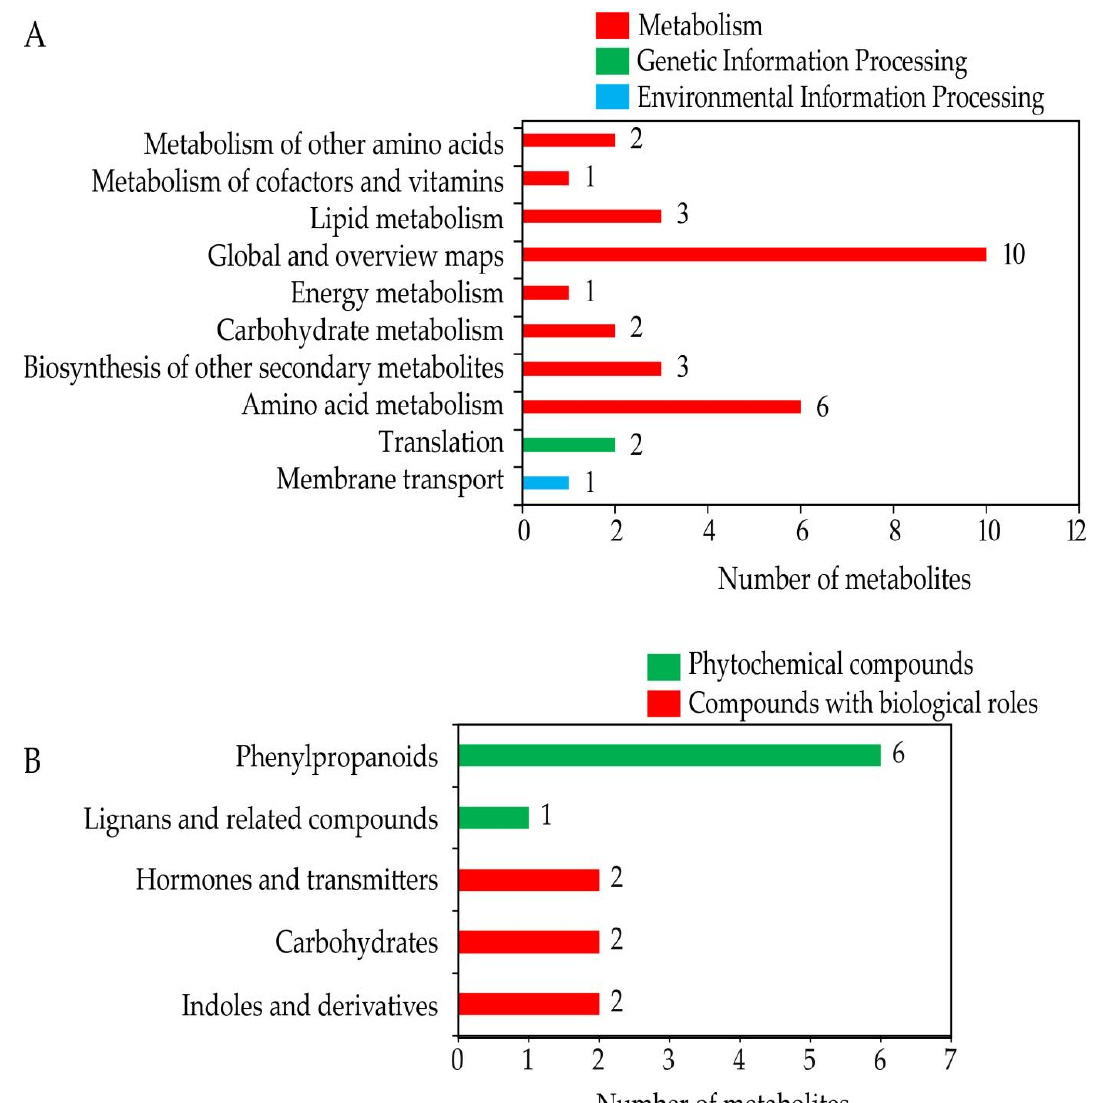
Figure 10. Combined analysis of transcriptomic and metabolomic data. ( A ) Classification of combined DEMs. ( B ) KEGG categories of combined DEMs.